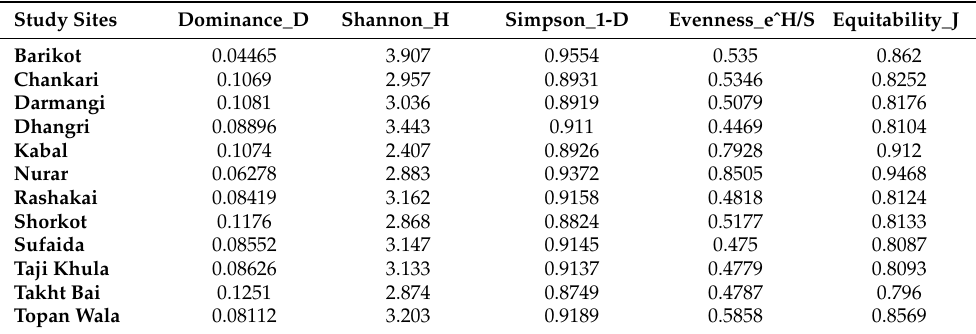
Table 7. Diversity and species richness of ticks in the studied areas of Khyber Pakhtunkhwa